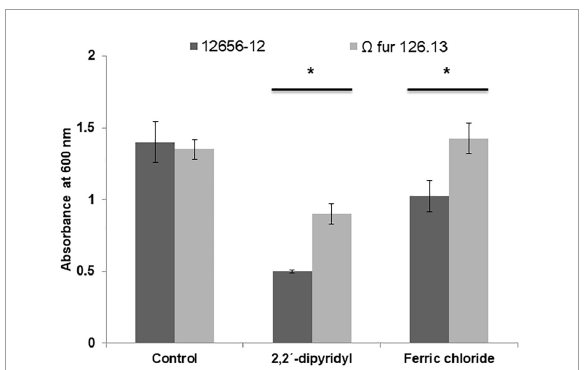
FIGURE7 Growth of G. anatis 12656-12 and (cid:127) fur 126.3 strains in 24-h cultures supplemented or not with 2,2 (cid:48) -dipyridyl or FeCl 3 . *Significant difference ( P < 0.05), compared with the control.